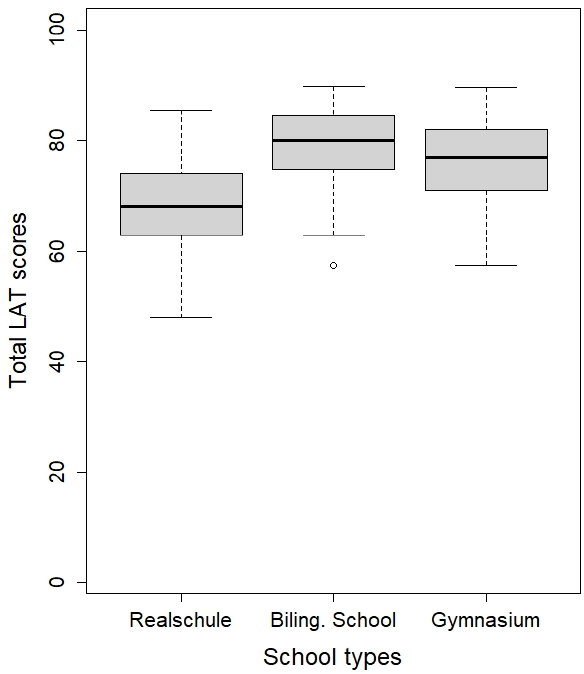
Figure 6. Total LAT scores across school types.